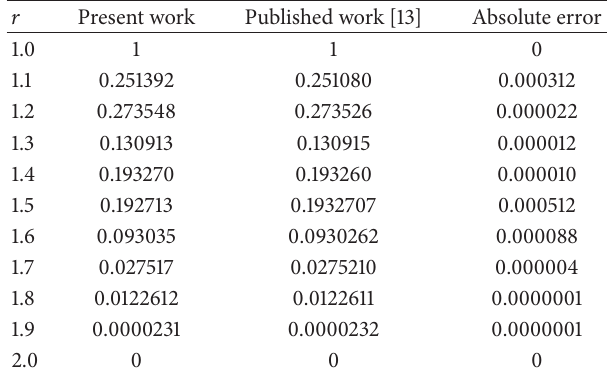
Table 3: Comparison of the present work with published work [13] when 𝛽 1 = 1 = 𝛽 2 , 𝜆 = 0.3 , 𝛿 = 2 , 𝐶 1 = −0.001243429 , 𝐶 2 =